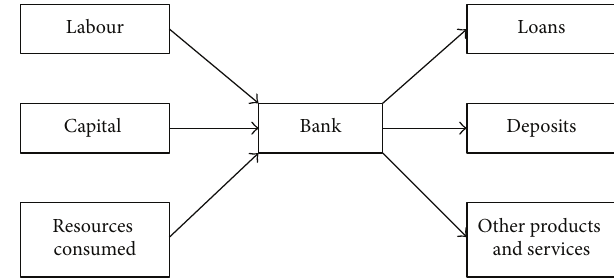
Figure 4: Production